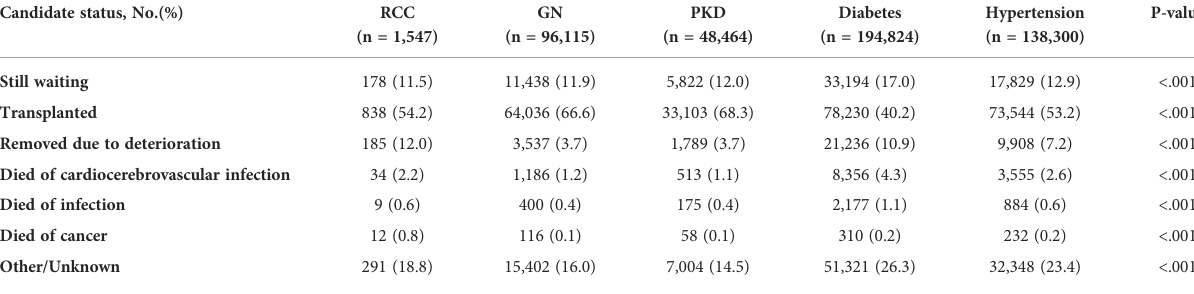
TABLE 2 Candidates ’ status and cause of death by primary